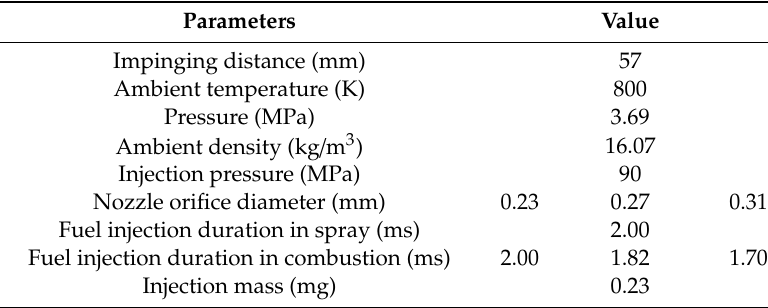
Table 2. Experiment operating settings.